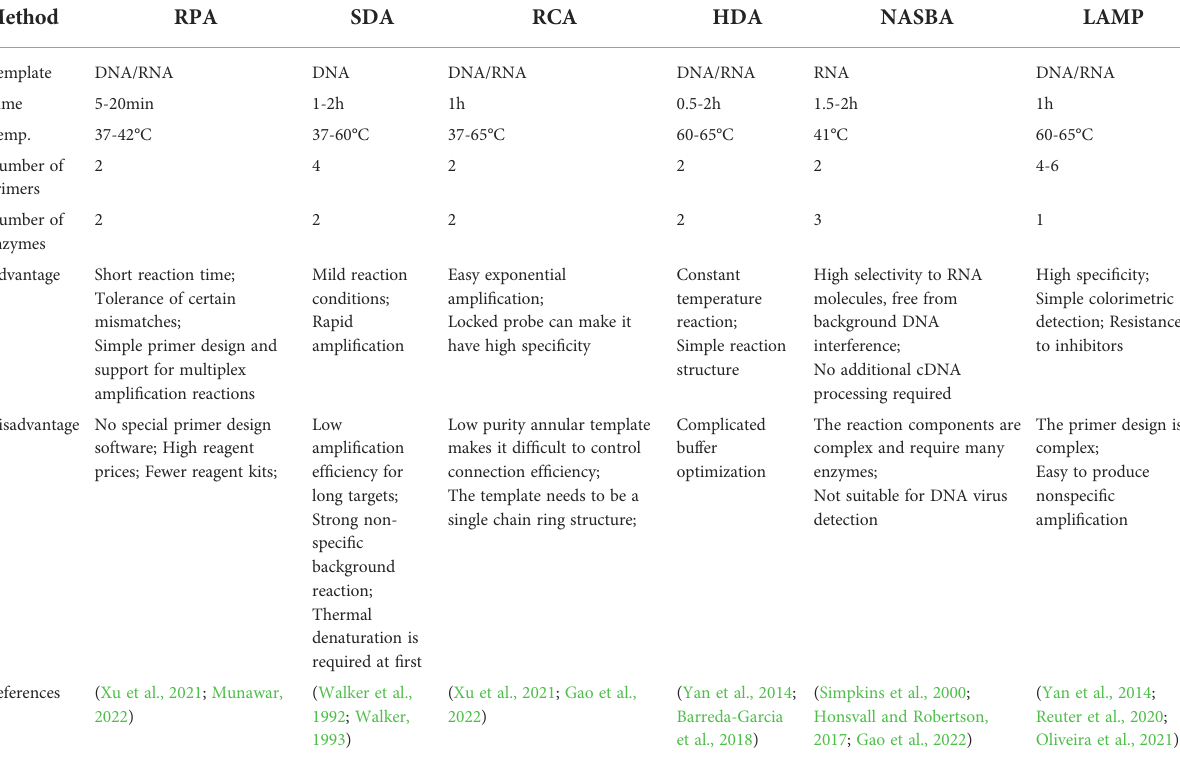
TABLE 2 Comparison of RPA and other common isothermal ampli fi cation methods.